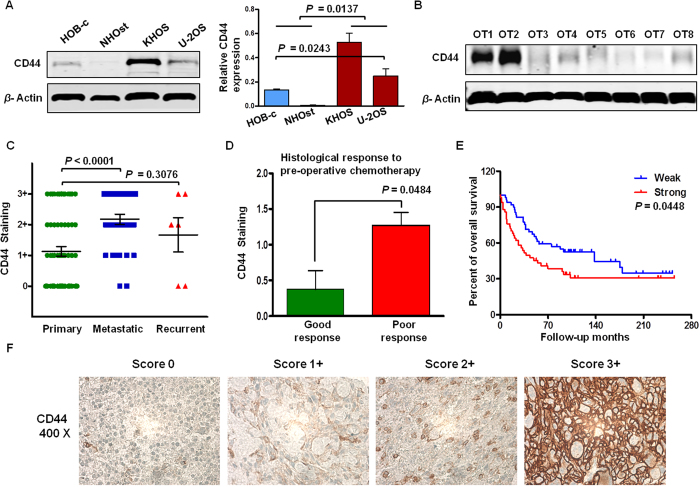
Expression of CD44 in osteosarcoma tissues, osteosarcoma/osteoblast cell lines, and its clinical significance.A expression levels of CD44 in osteoblast and osteosarcoma cell lines were assessed by western blot. B expression levels of CD44 in eight osteosarcoma tissue specimens was determined by western blot. C distribution of CD44 immunohistochemical staining scores in primary, metastatic, and recurrent osteosarcoma tissues. D comparison of CD44 immunostaining density between good response and poor response osteosarcoma tissues based on the histological necrosis percentage after pre-operation chemotherapy. E correlation between expression of CD44 (CD44 staining ≤ 1+ and CD44 staining ≥ 2+) and overall survival in osteosarcoma patients. F representative pictures of CD44 expression in osteosarcoma tissues.